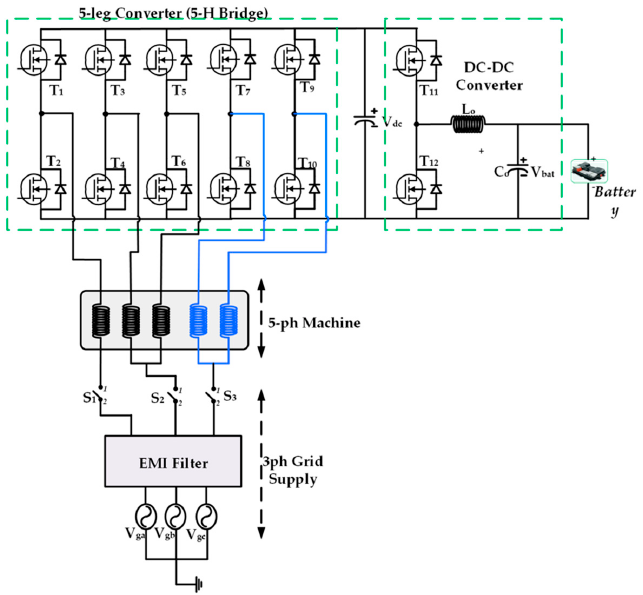
Figure 18. Integrated On − Board Charger based on Five Phase Winding Machine proposed by Sabotic et al. [88] in 2016 (iOBC14).